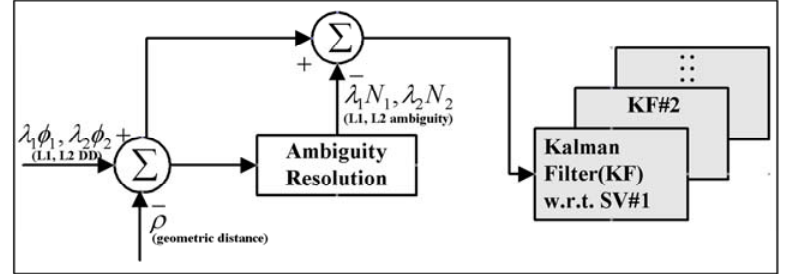
Figure 2. An estimation procedure for GPS baseline-dependent error utilising the Kalman